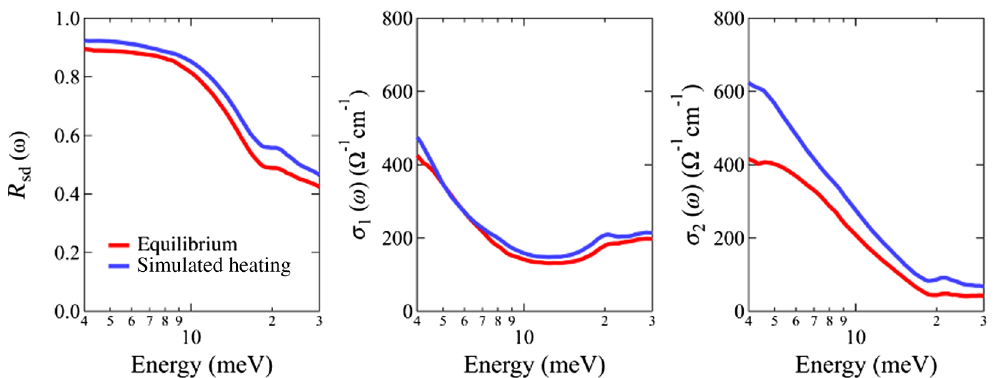
FIG. 8. Simulated reflectivity (sample-diamond interface) and real and imaginary parts of the optical conductivity, retrieved using the procedure described in Appendix C for a pump-induced heating-only